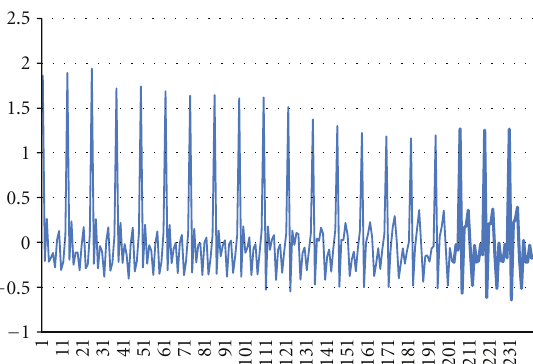
Figure 4: A sample time series represented in LPC coe ffi cient produced by utterance of Japanese